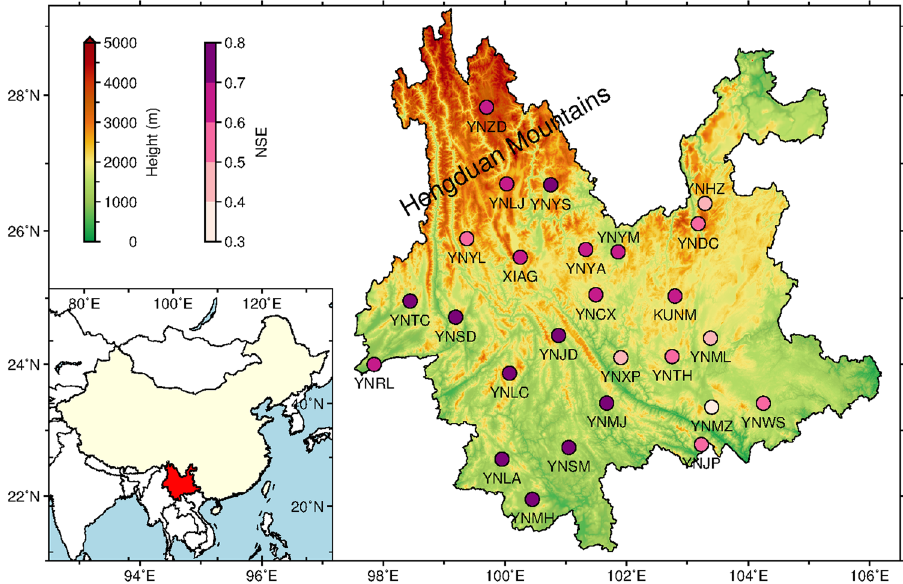
Figure 1. Location map of the 26 Continuous GPS stations in Yunnan, China, and their Nash-Sutcliffe efficiency (NSE) when their GPS-derived VCD are compared with GRACE-derived VCD. This figure is generated by using the Generic Mapping Tools (Version 5.3.1) 26